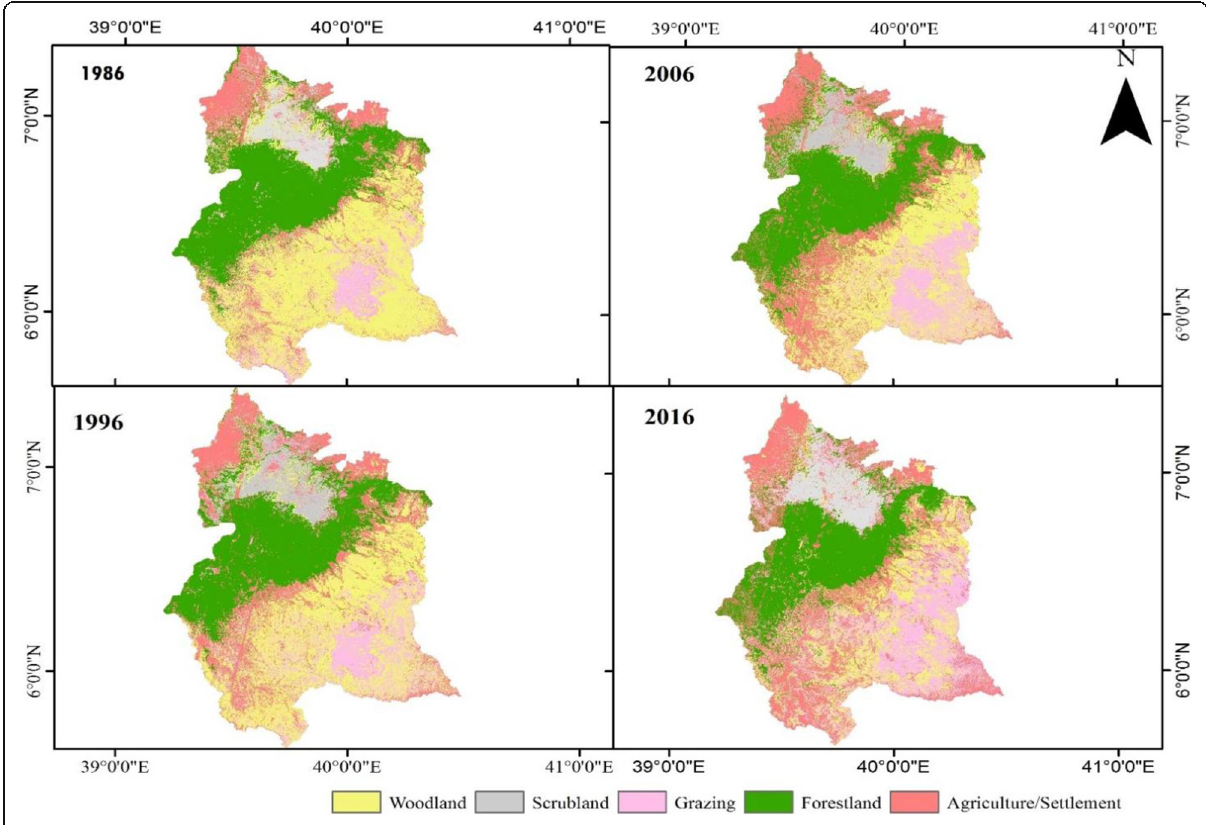
Fig. 2 Spatial pattern of afro-alpine forest change in Bale eco-region from 1986 to 2016